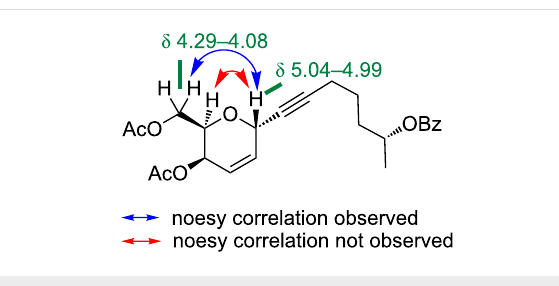
Figure 2: Key NOESY correlations observed in compound 11